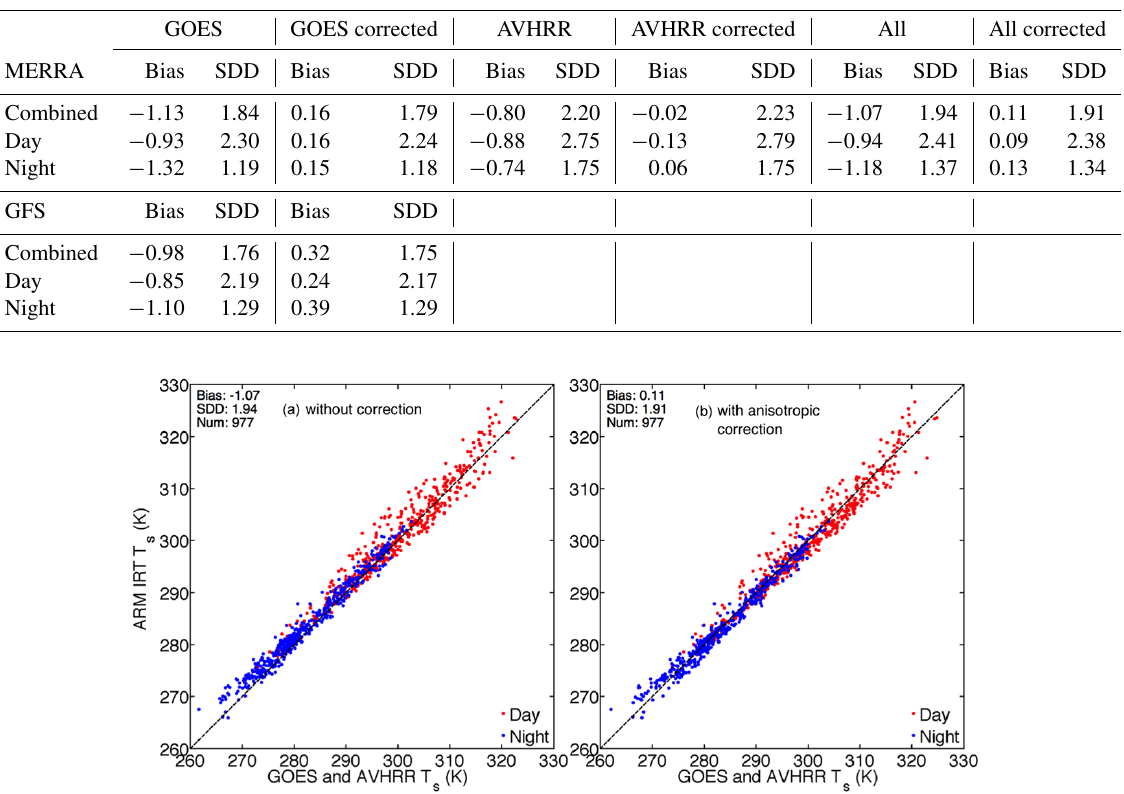
Table 4. Mean bias and SDD values (K) based on results relative to the ARM IRT before and after anisotropic correction using only GOES data, only 2013 AVHRR data, and using combined 2013 GOES and AVHRR results (All). GOES SatCORPS retrievals are based on MERRA (top) and GFS (bottom) input.